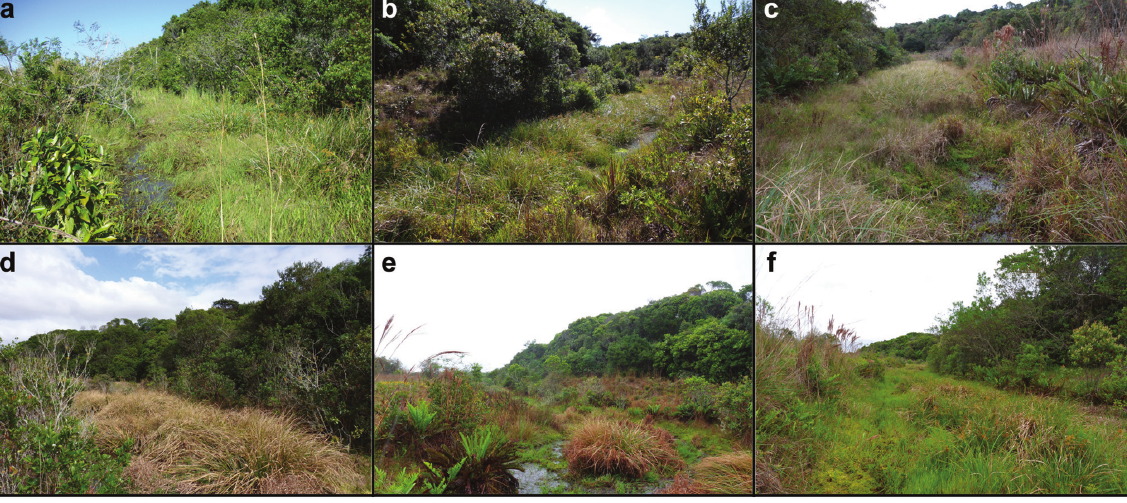
Fig. 2. Sampling area of Atlantirivulus riograndensis . Evidence of seasonal modification of landscape at the collection point at Banhado dos Pachecos wildlife refuge, Viamão, Rio Grande do Sul, Brazil, during the year 2012 (a) Summer in March; Autumn in (b) May and (c) in June; (d) Winter in September; Spring in (e) October and (f)